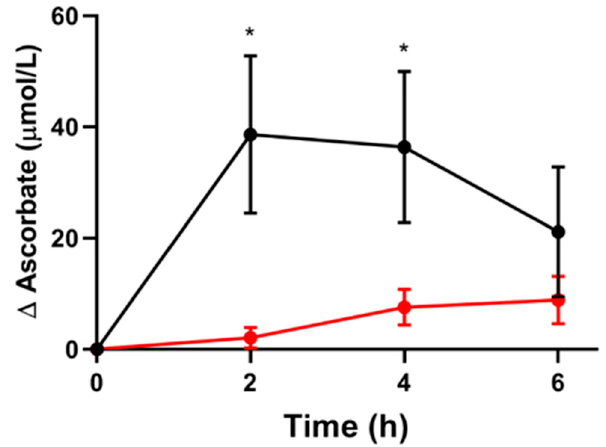
Figure 3. Pharmacokinetic study. The change in plasma ( ● ) and erythrocyte ( ● ) ascorbate following ingestion of 200 mg of vitamin C. The zero time point is fasting, with supplementation occurring immediately after this sample was taken. The data represent the mean ± SEM (n = 6). The baseline ascorbate concentrations were 67.2 ± 8.8 µmol/L and 58.7 ± 4.6 µmol/L for plasma and erythrocytes, respectively. Paired t-tests indicate that erythrocyte ascorbate time points were not significantly different from the baseline, whereas plasma ascorbate was different from the baseline at 2 and 4 h ( p < 0.05). Furthermore, erythrocyte and plasma ascorbate were significantly different from each other at the time points indicated * ( p < 0.02).